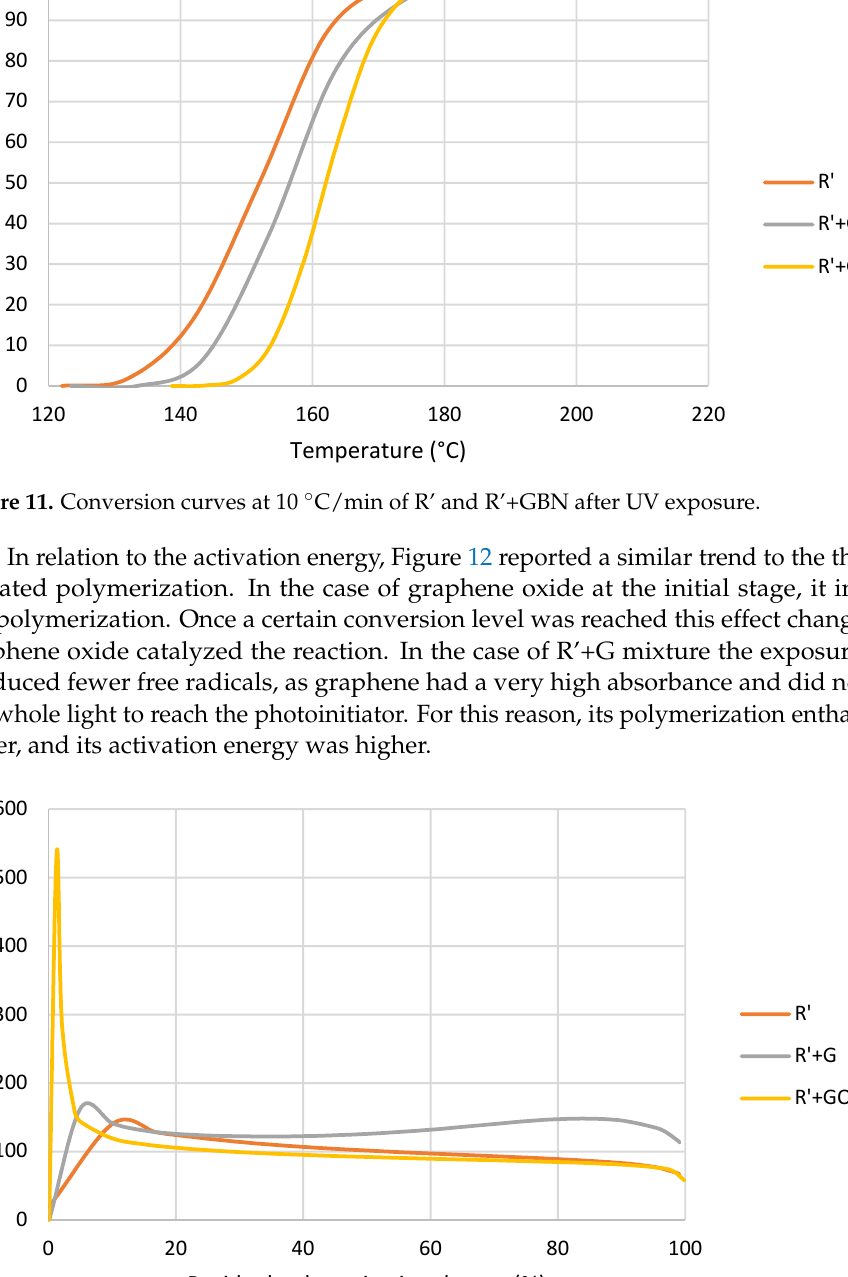
Figure 12. Activation energy as a function of residual conversion degree of R’ and R’+GBN after UV exposure obtained by MFK model.